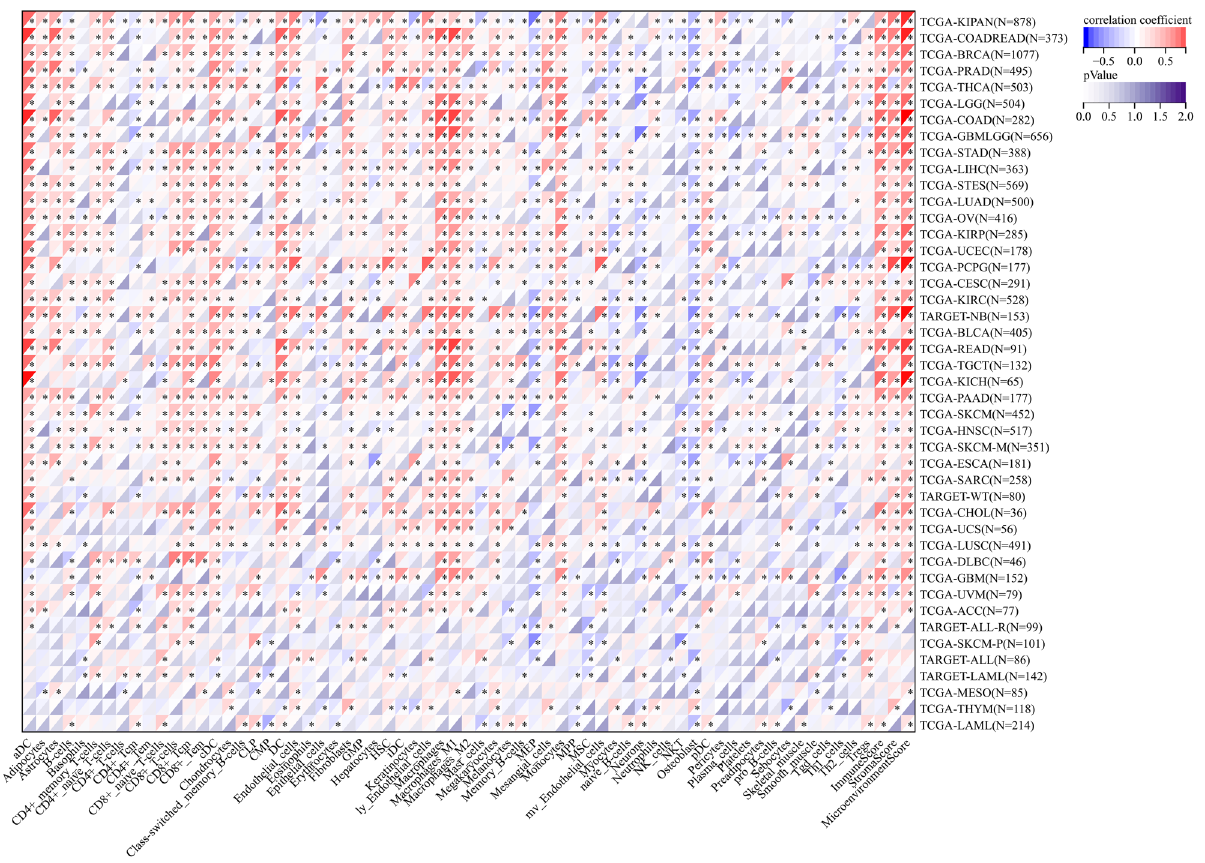
Figure 9. Association of CLEC2B expression and immune cell infiltration using XCELL